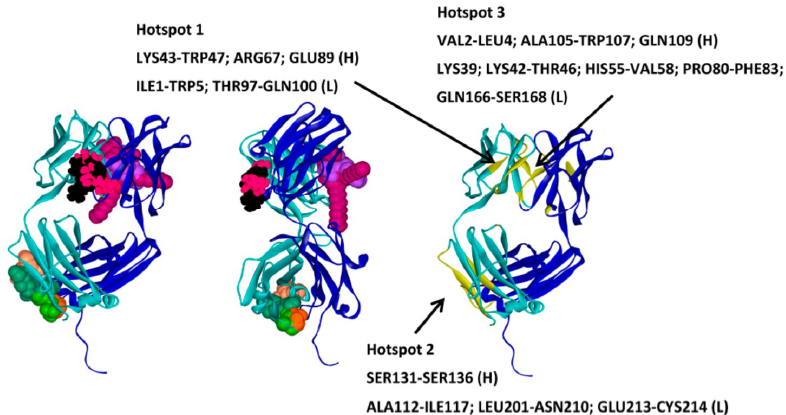
Figure 7. Binding hotspots for eight commercial excipients on the A33Fab surface. Reprinted from [156] with permission.